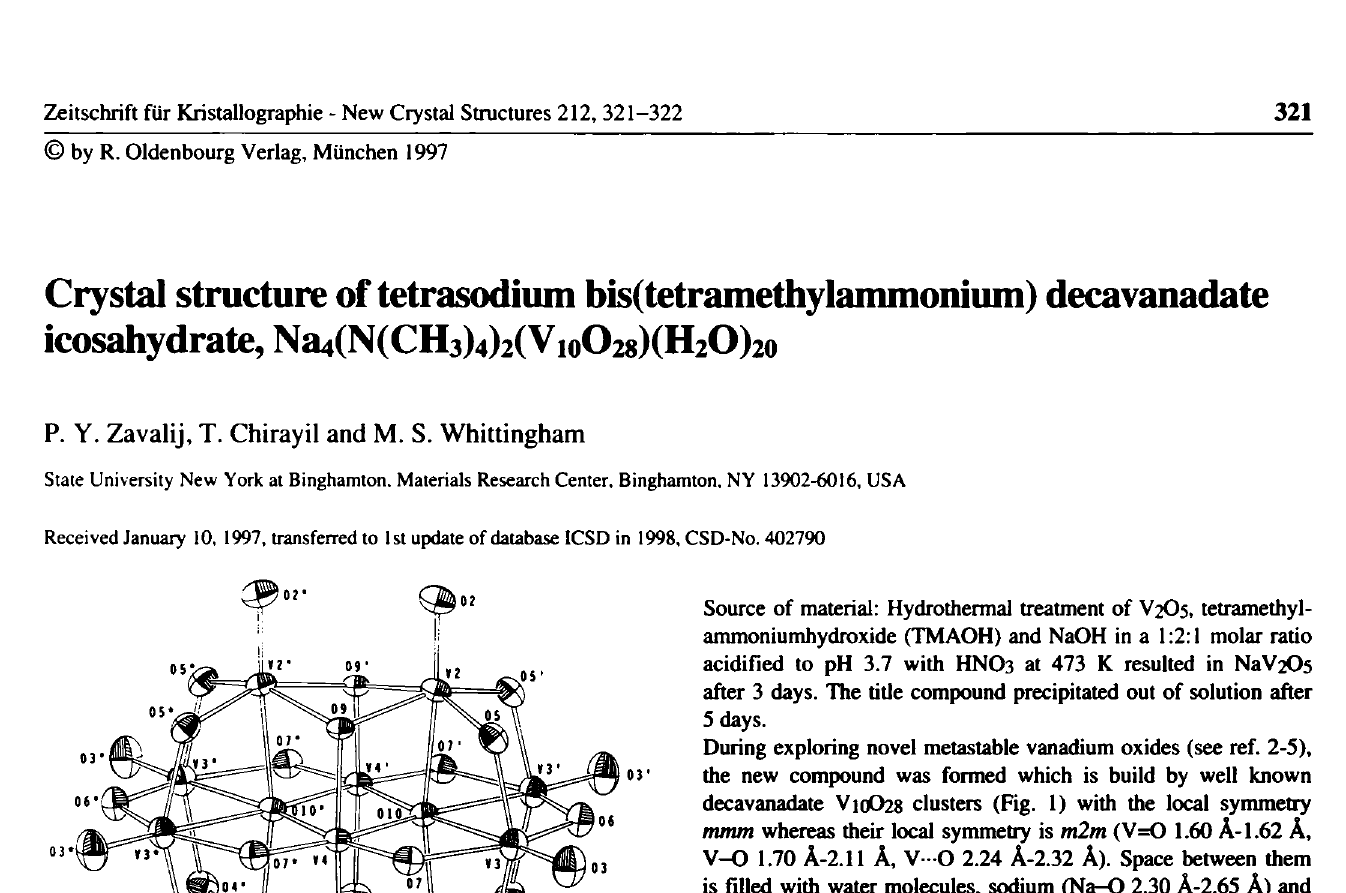
Table 1. Parameters used for the X-ray data collection Crystal: